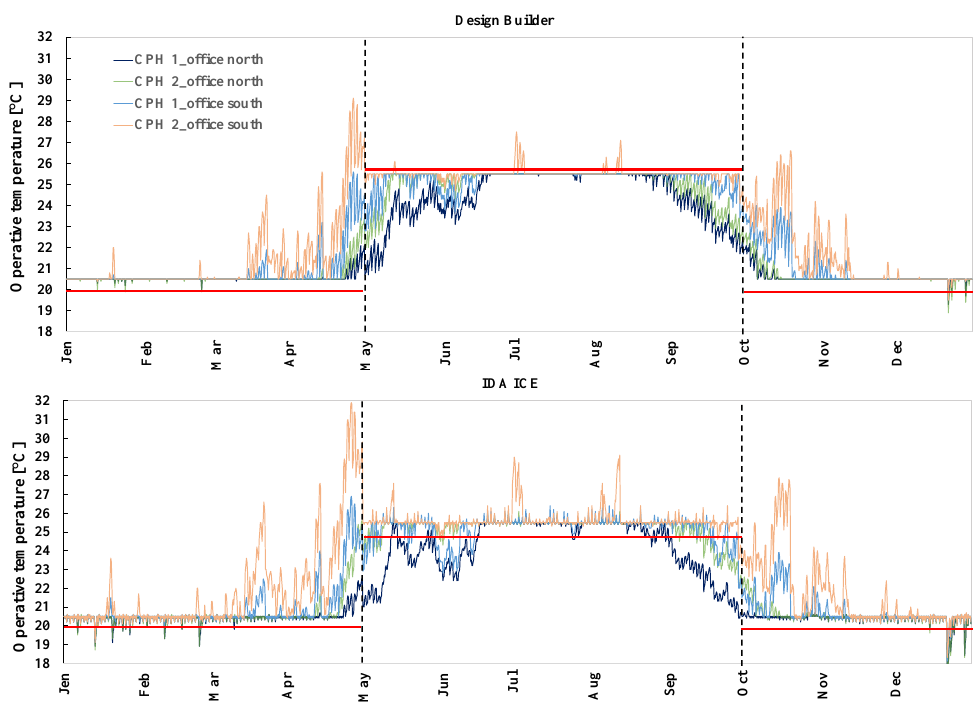
Figure 2. Operative temperature for Copenhagen in Design Builder (up) and IDA ICE (down). Dashed black lines are the limits of the seasons (winter/summer) and the red lines are the limits of the ranges of thermal comfort according to standard EN 16798-1 [8] for the heating and cooling season. CPH 1: Copenhagen/scenario 1, CPH 2: Copenhagen/scenario 2.